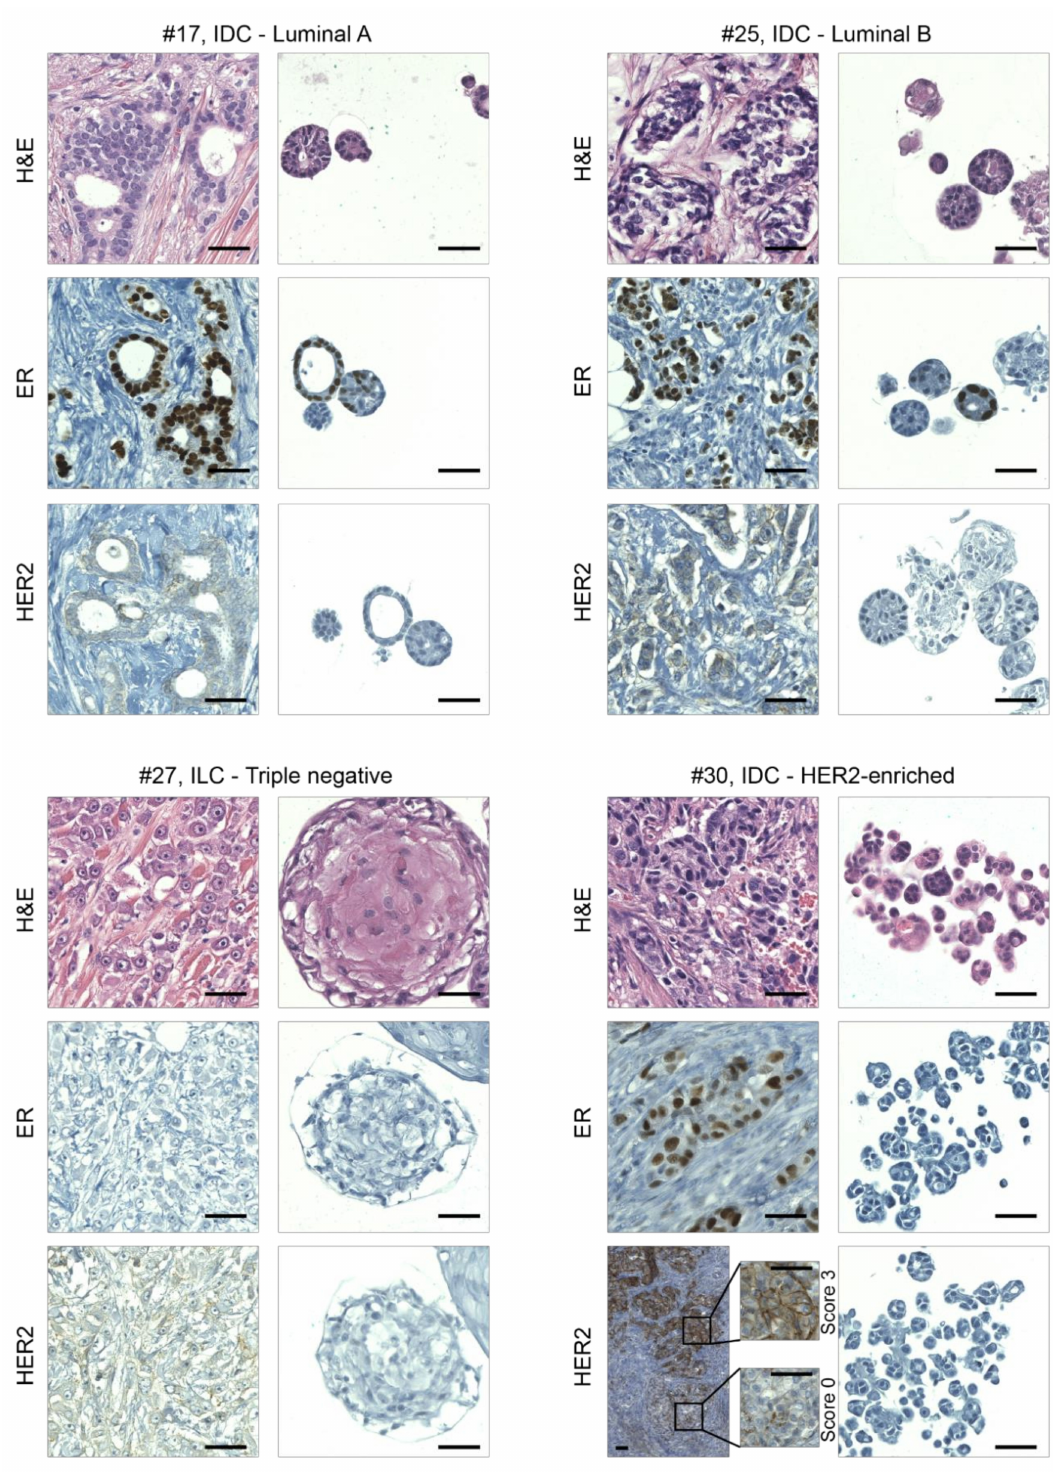
Figure 2. Organoids recapitulate the histological features of primary BCs. Representative images of hematoxylin / eosin staining (H&E) and immunohistochemical analyses on sections of BCs and derived organoids. From left to right and from the top to the bottom are examples of luminal A, luminal B, triple negative, and HER2-enriched BCs, respectively; IDC, invasive ductal carcinoma; ILC, invasive lobular carcinoma; ER, estrogen receptor; HER2, human epidermal growth factor receptor 2. Magnifications of HER2 staining in di ff erent areas of cancer tissue #30 are also shown. Scale bar, 100 µ